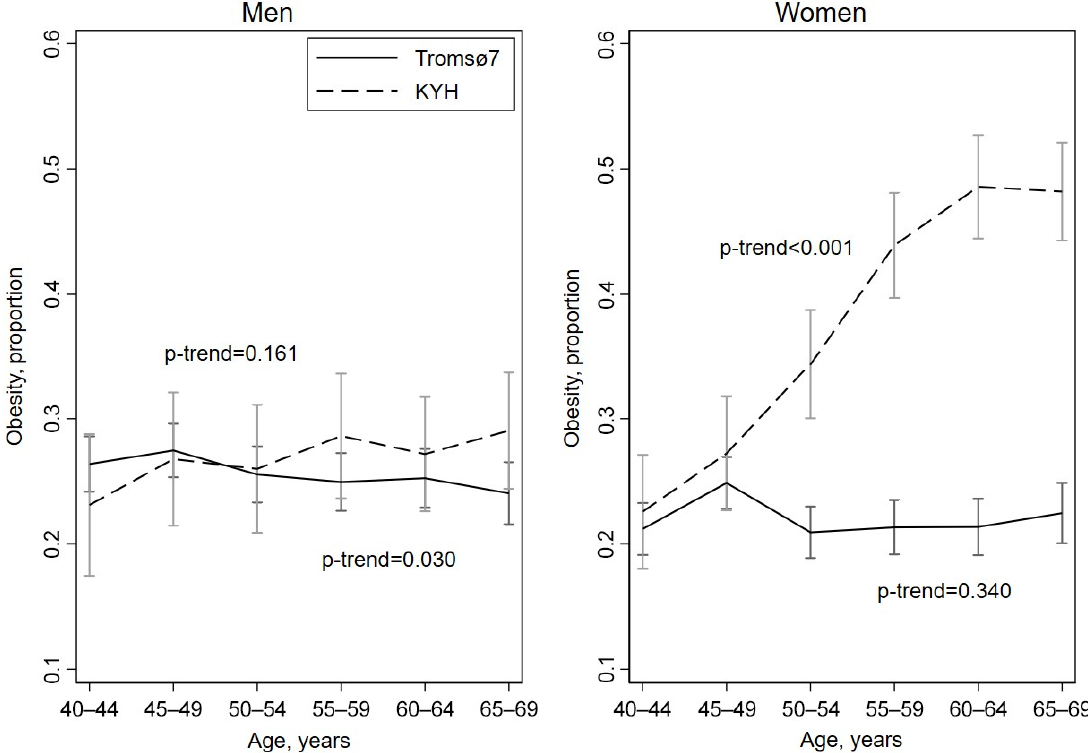
Figure 1. Prevalence of general obesity (BMI ≥ 30 kg/m 2 ) with 95% confidence intervals by study, sex and